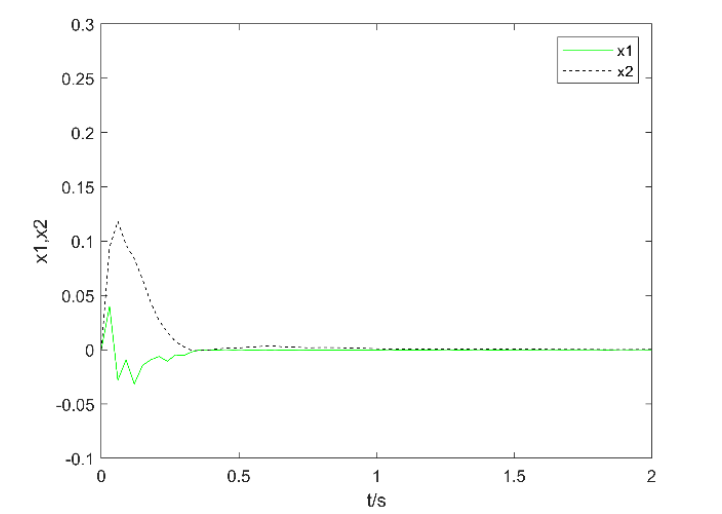
Figure 2. The state responses for system